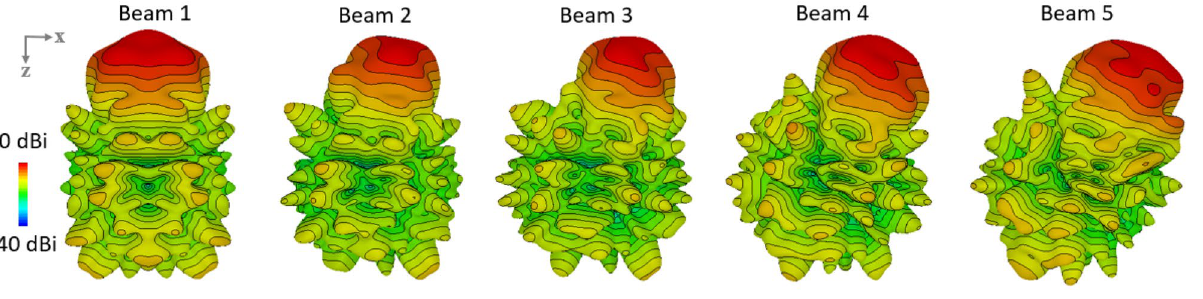
Figure 5. Beam steering as a response to the phase